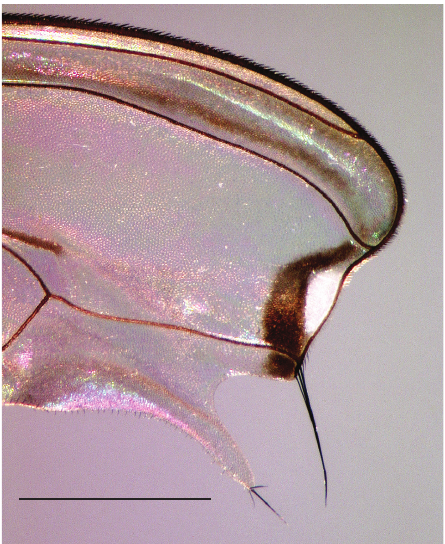
Figure 7. Wing tip of male Liancalus pterodactyl sp. n., showing white reflectance of apical spot in cer- tain lights. Scale bar = 1